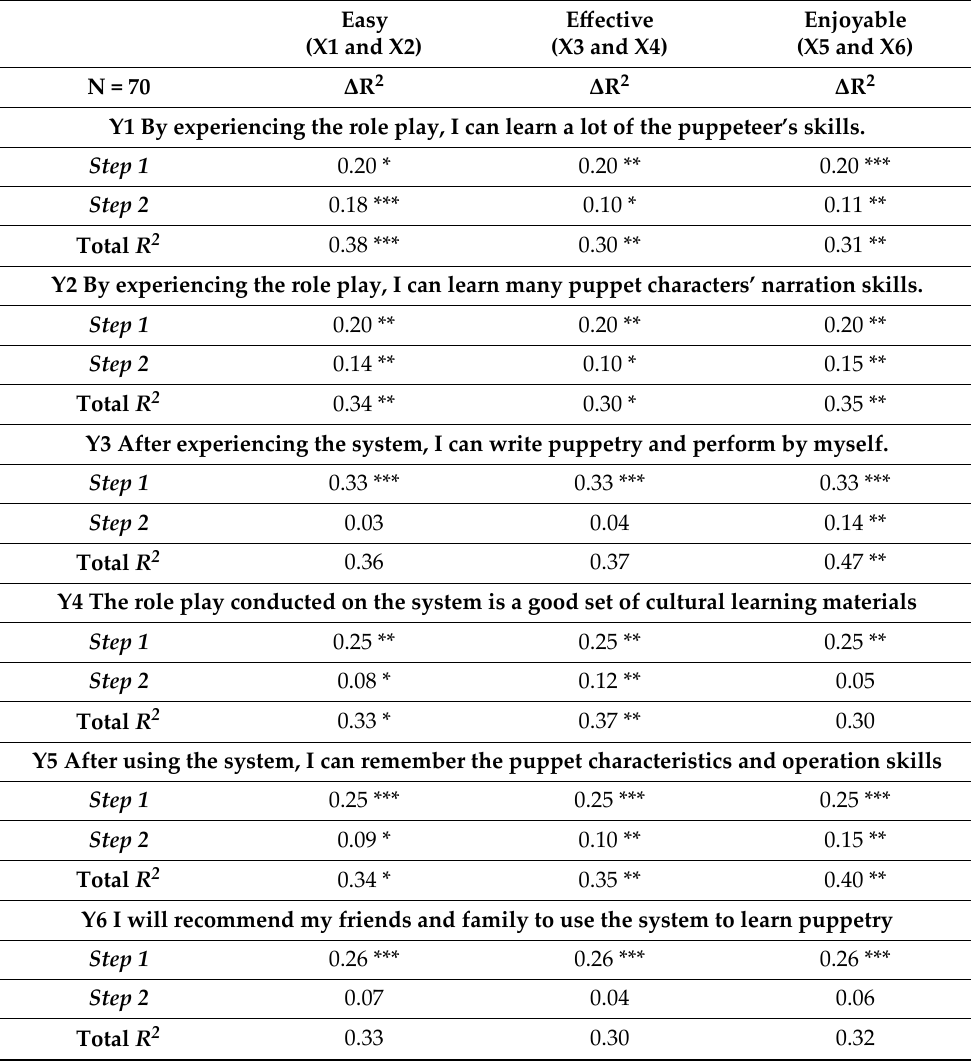
Table 13. The integrated data of changes of coefficient of determination ∆ R 2 of the two steps of regressions for all